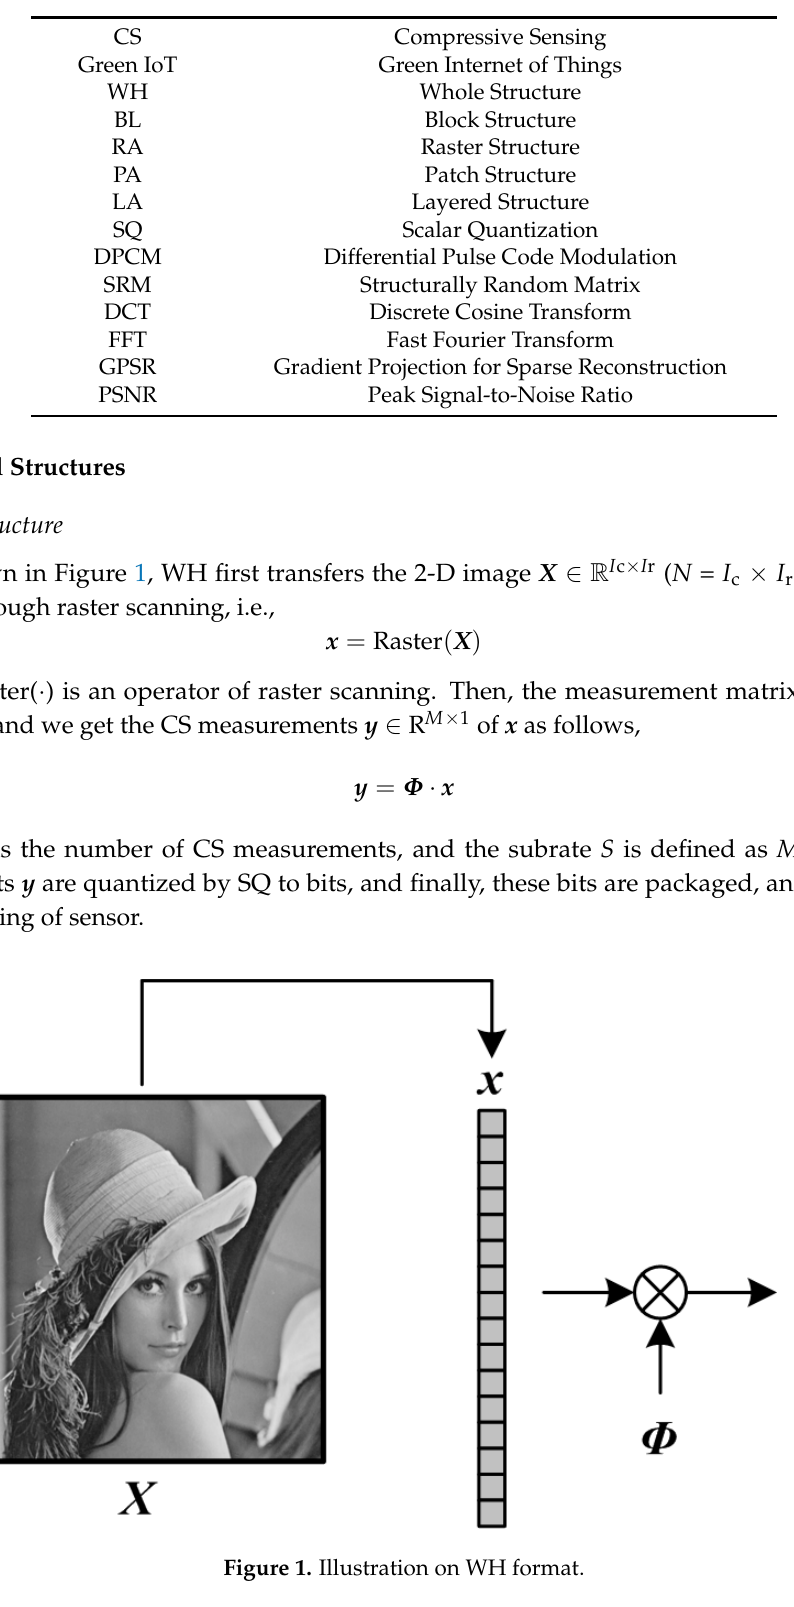
Table 1. List of acronyms and notations.